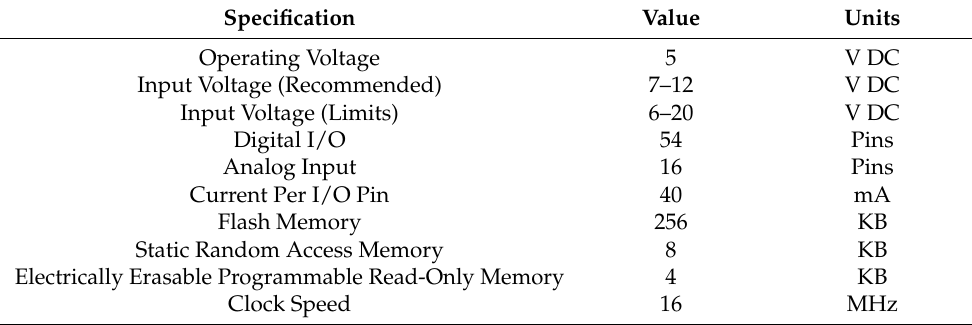
Table 8. Technical specifications of RTU